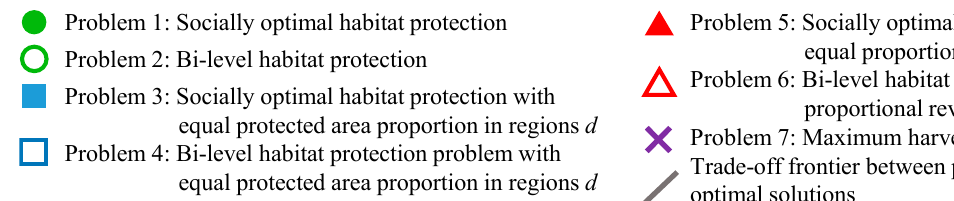
Figure 4. Trade-offs between problem 1–7 optimal solutions in dimensions of total harvest revenue and the amount of protected habitat in the range area: ( a ) optimal solutions for the protected habitat target S = 0.65; ( b ) optimal solutions for S = 0.4. The protected habitat amount is depicted as the dimensionless scores.